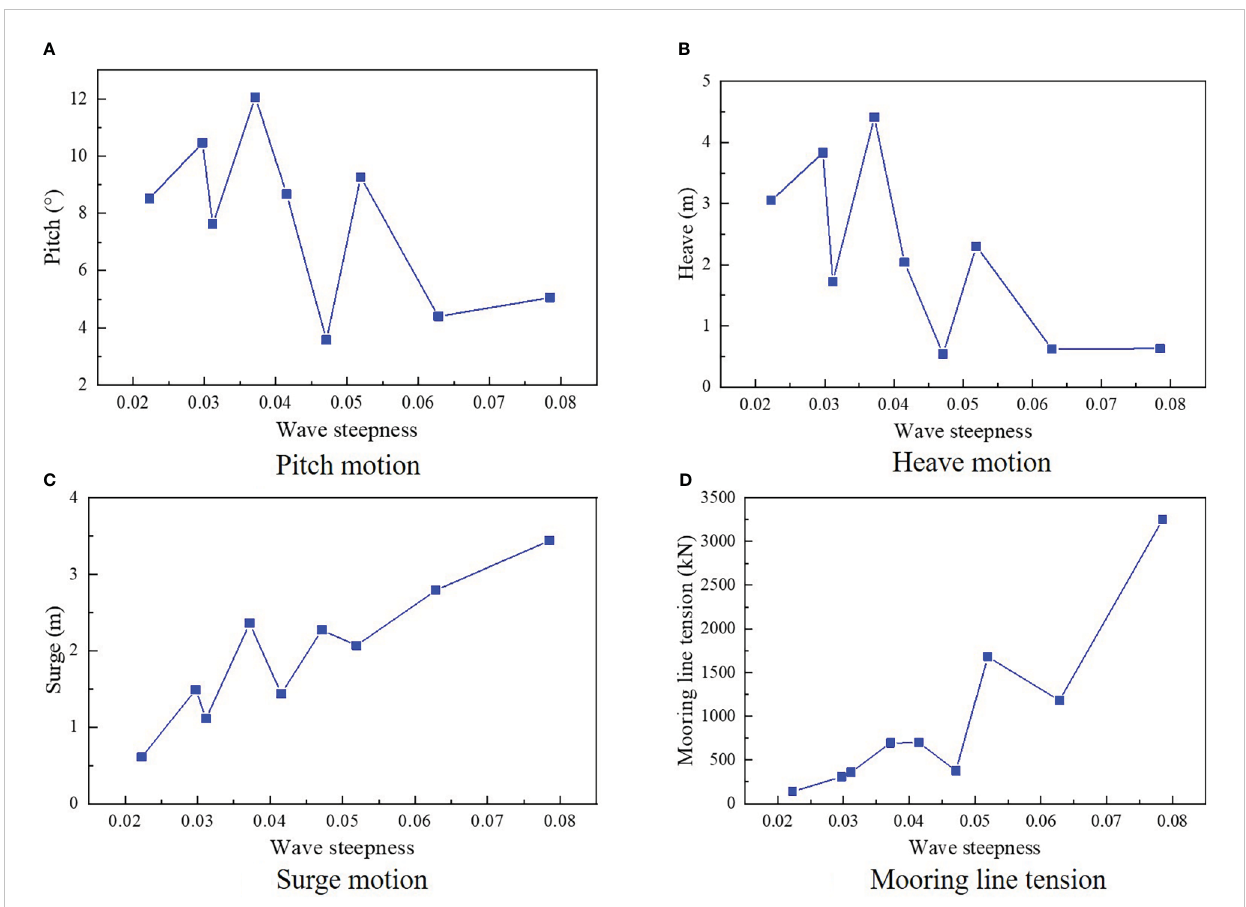
FIGURE 13 Motion response and mooring line tension of fi sh farm platform under different wave